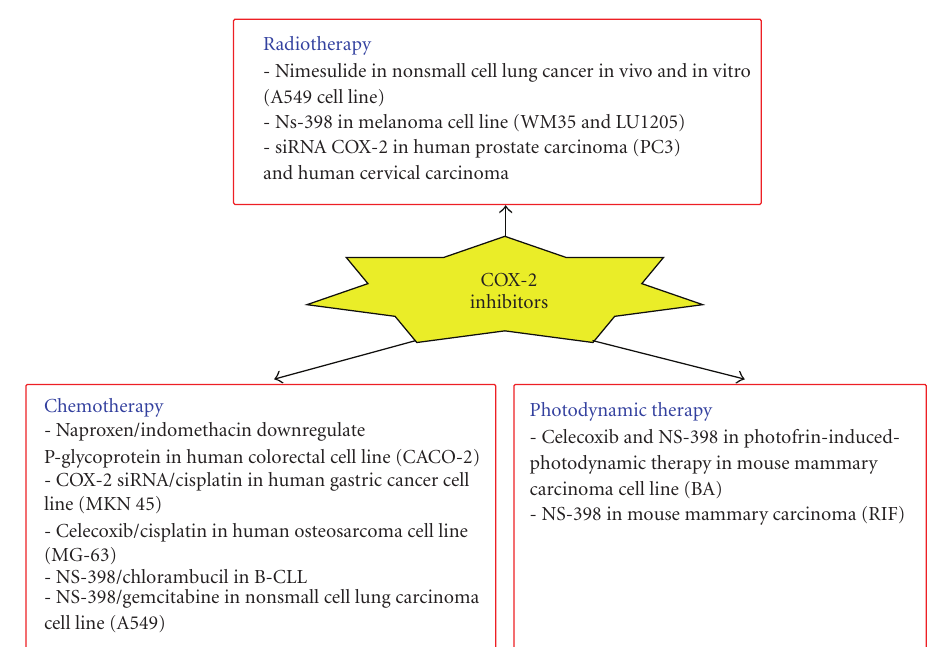
Figure 5: COX-2 inhibition in cancer